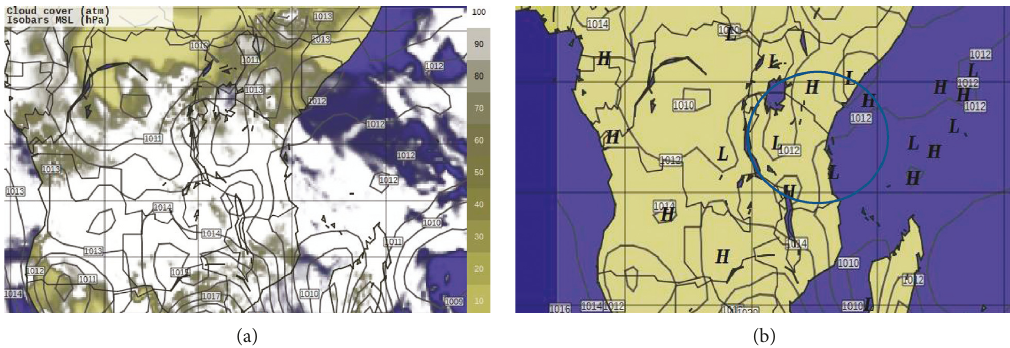
Figure 2: Cloud cover overlaid with the mean sea level pressure (a) and surface high- and low-pressure centers (b) at 0900 UTC. The low- pressure centers are an indication of areas of surface convergence. All maps were from NOAA-GFS, Wednesday 2018-01-10 06 :00 UTC, generated using zyGRID-Grib files visualization software (available at http://www.zygrib.org/).